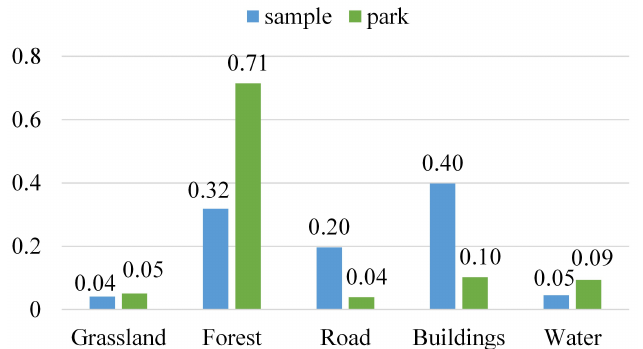
Figure 4. Land cover category distribution of all samples and park